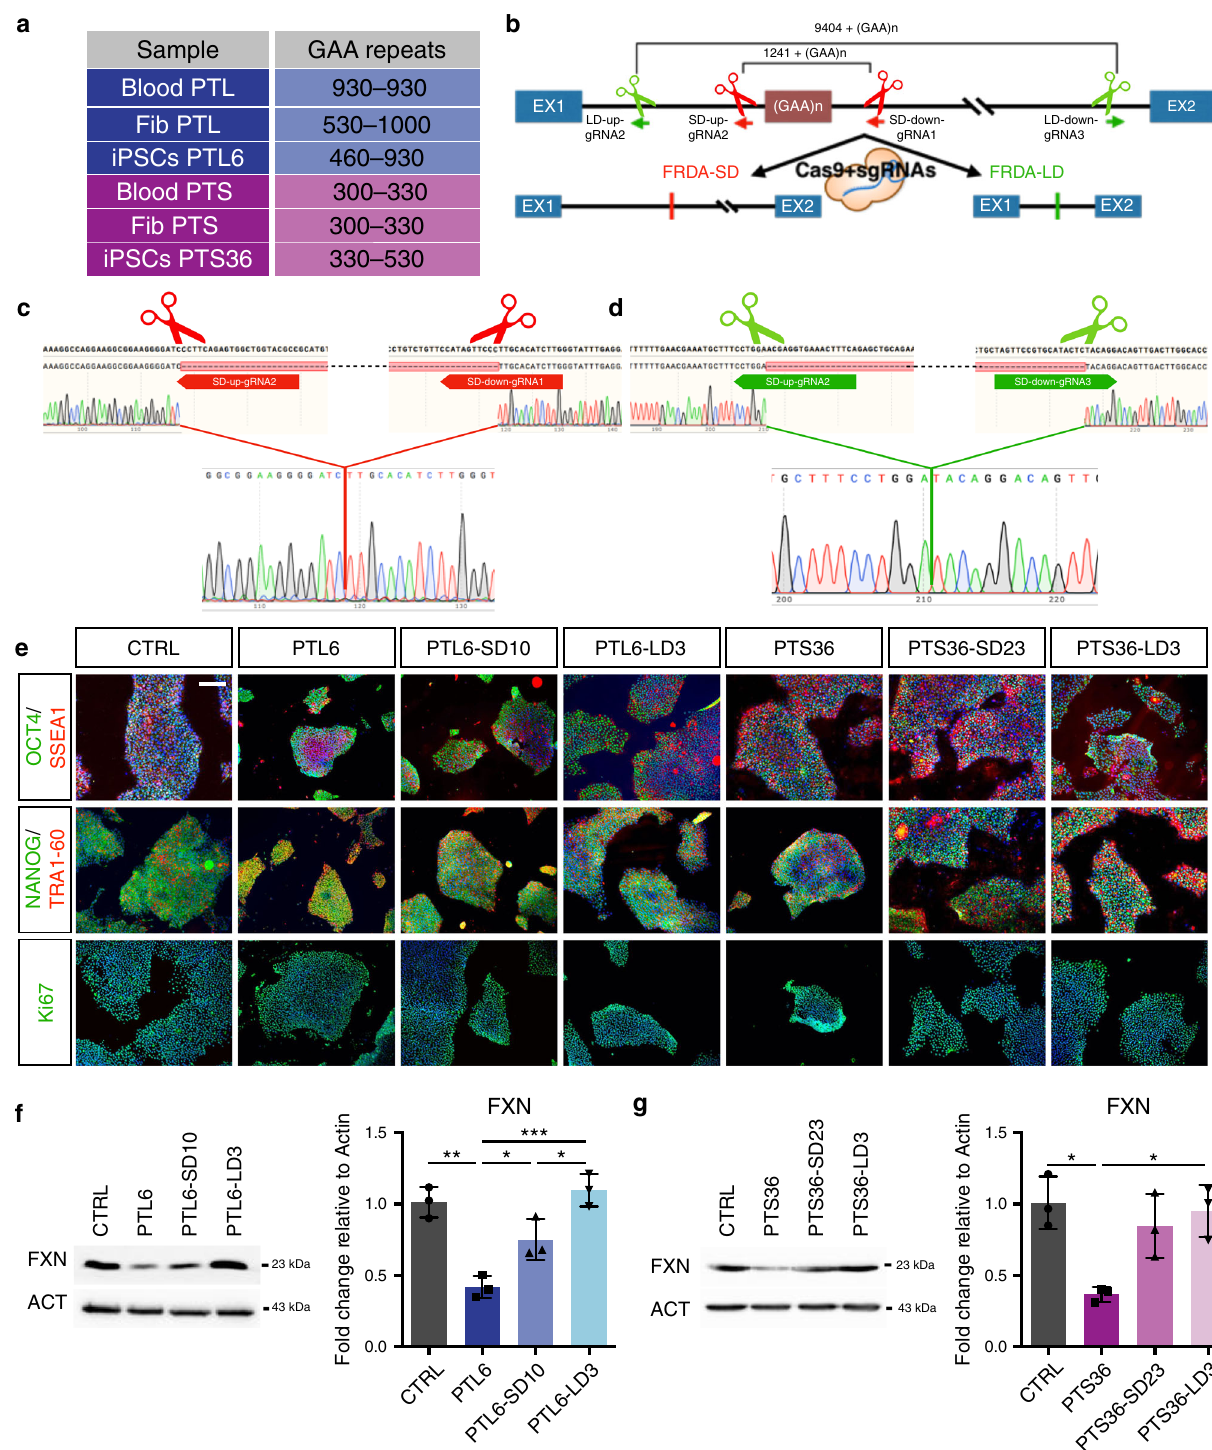
Fig. 1 Generation of FRDA patient and isogenic CRISPR/Cas9 targeted iPSCs. a Annotation of GAA repeats in different cell lines from FRDA patients PTS and PTL. b Illustration of CRISPR-based deletions in FXN intron 1. Pairs of sgRNAs drive Cas9-based targeted excision to proximal sites (red) fl anking the GAA tract and long distal sites (green). Thus, short (SD) or long deletions (LD) of the FXN intron 1 are generated in FRDA-SD and FRDA-LD iPSC lines, respectively. c , d Representative Sanger sequencing con fi rming the generation of the short ( c ) and long deletion ( d ) in FRDA patient iPSCs. e Immunocytochemistry of the crucial pluripotency markers OCT4, NANOG, SSEA1 and TRA-1-60 on CTRL and untreated or targeted patient iPSCs. Scale bar, 100 μ m. f , g Quantitative analysis of frataxin protein levels in PTL6 ( f ) and PTS36 ( g ) and their relative targeted iPSC lines. Protein levels are normalized to Actin. Mean ± s.d., n = 3 independent experiments, 24 – 36 organoids/line/experiment. * P < 0.05; ** P < 0.01; *** P < 0.001; one-way ANOVA with Bonferroni